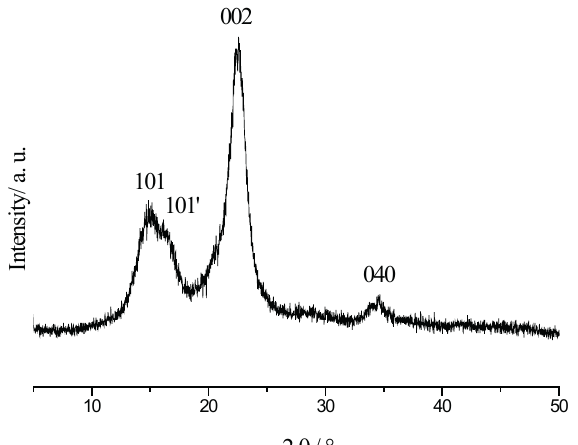
Figure 3: 13 C NMR spectrum of cellulose.